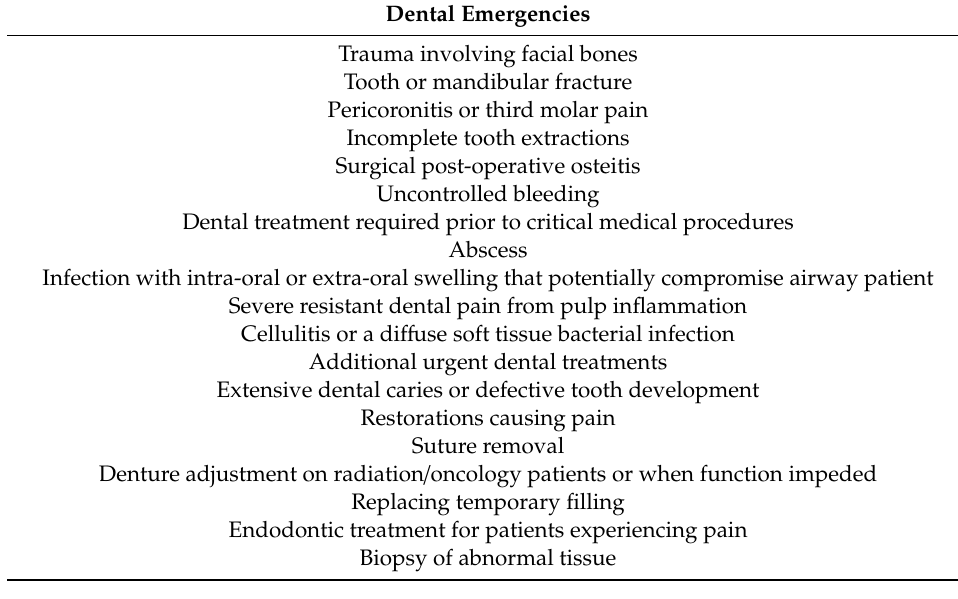
Table 1. The table shows the emergencies and urgent dental treatments that must be delivered even in a SARS CoV-2 pandemic, recommended by the American Dental